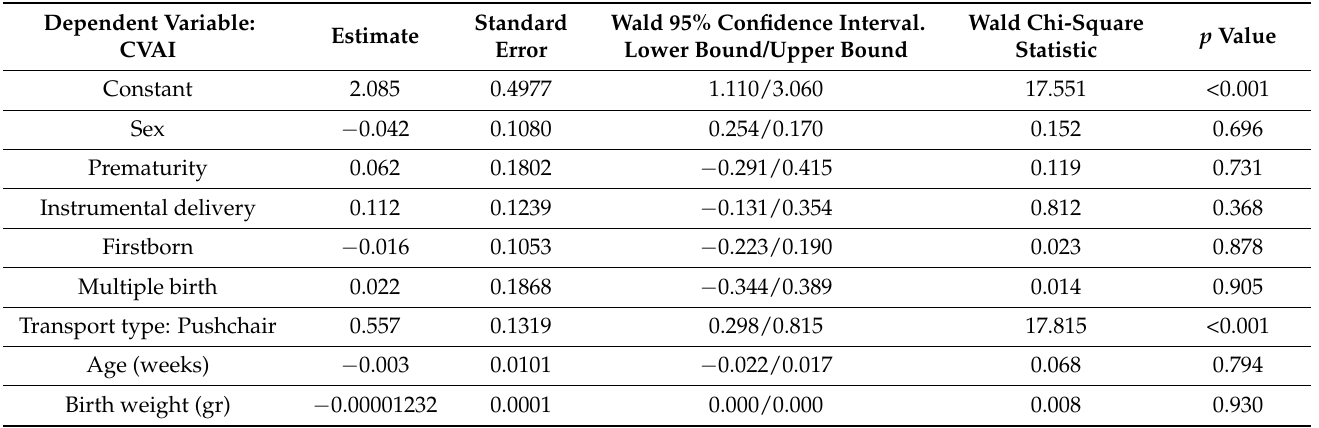
Table 2. Model effects with the total active cervical rotation ROM as a